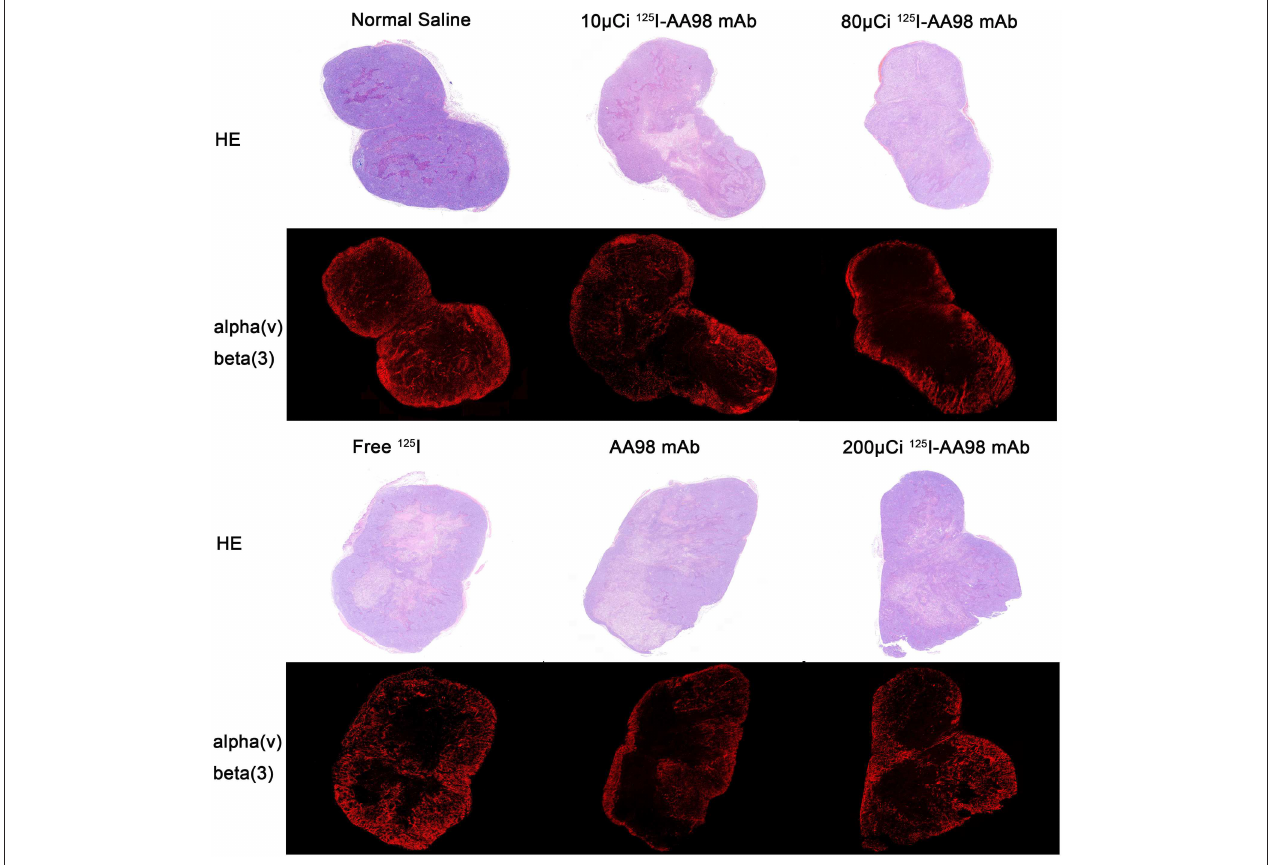
FIGURE 4 | Photographs of pair-matched HE staining and integrin α ν β 3 fluorescence staining 7 days after intratumoral injection in each